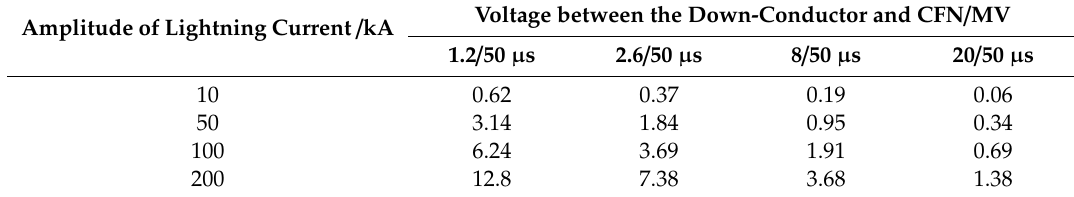
Table 3. Voltage between the down-conductor and CFN.